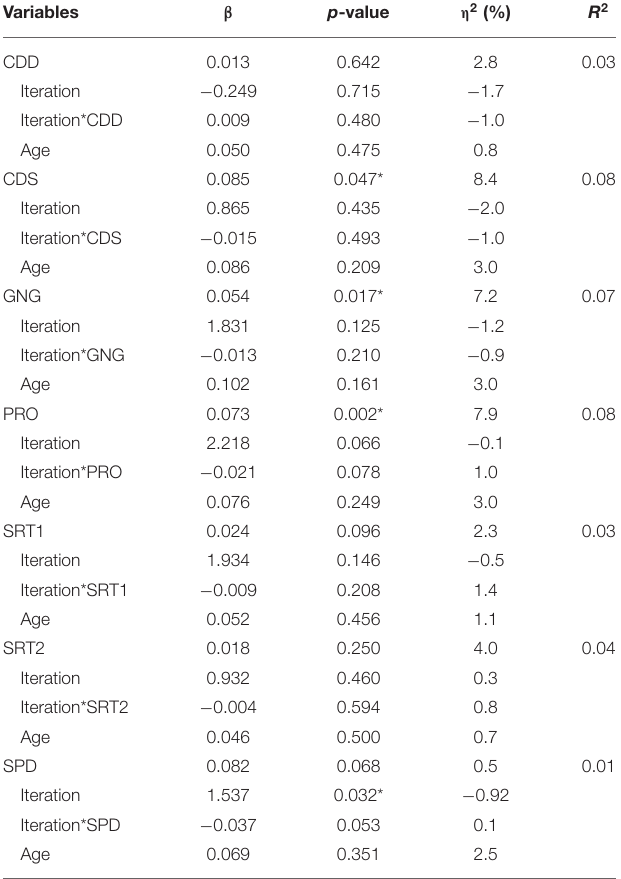
TABLE 3 | Results of comparison between the DANA Brief subtest mean throughput scores and MACE cognitive test scores in the final linear mixed model (Equation